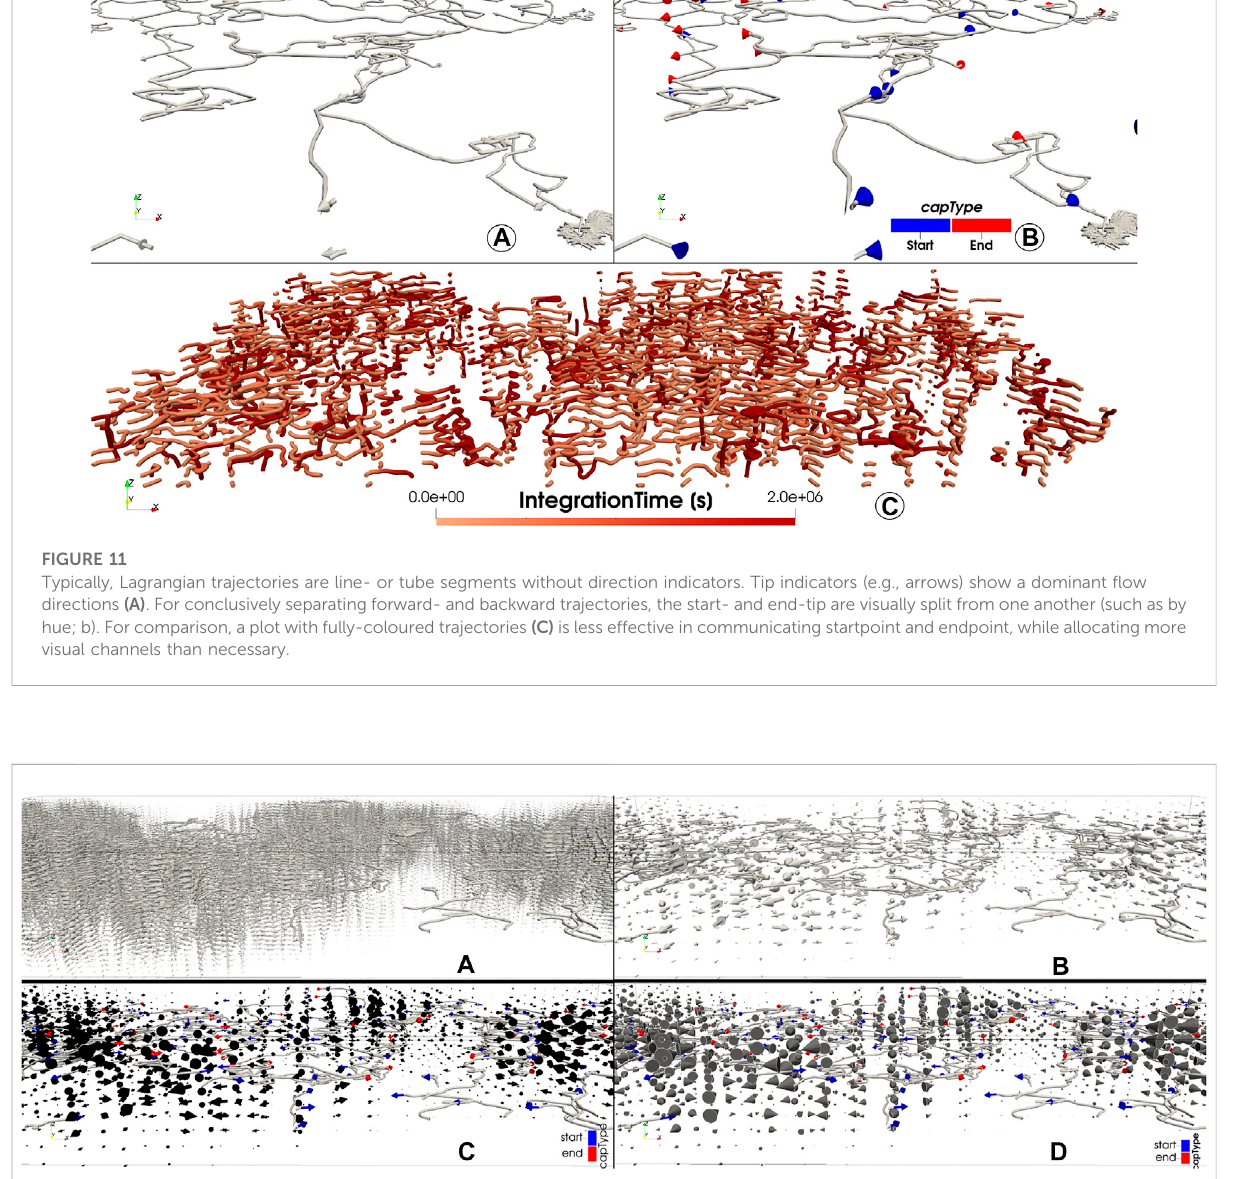
FIGURE 12 Visualisation variations by combining hedgehog plots for Eulerian fl uid fl ow velocity fi elds and Lagrangian particle trajectories: (A) original hedgehog, (B) sparse hedgehog, (C) coloured hedgehogs and trajectory indicators, (D) contoured- and shaded hedgehog and trajectory